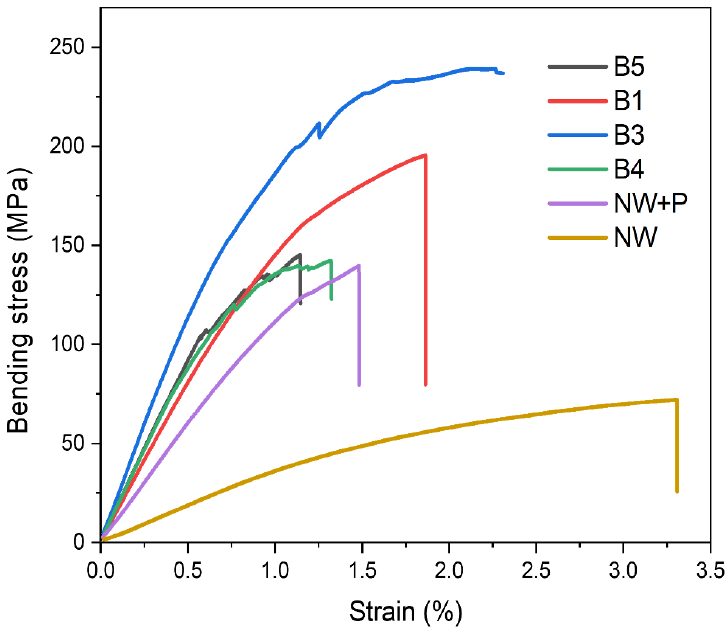
Figure 6. Stress-strain curves of wood specimens under HP-3 hot-pressing conditions (NW: natural